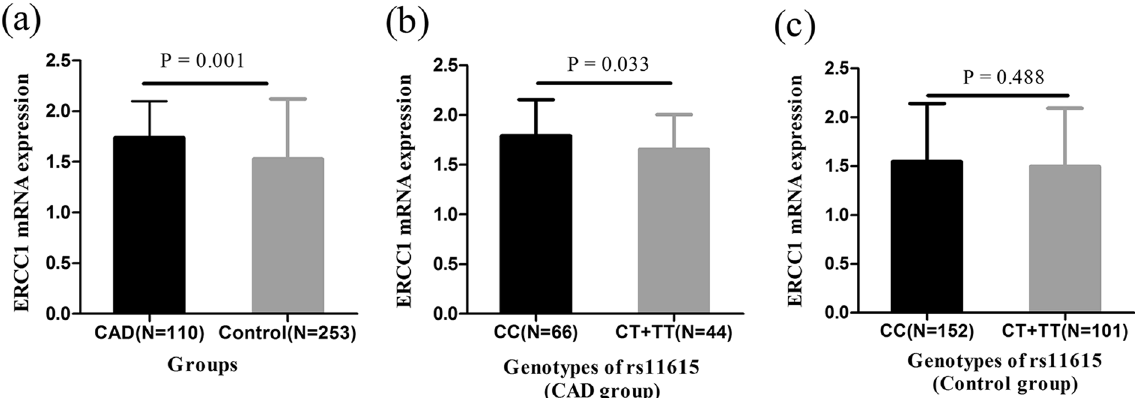
Figure 3. Associations of SNP rs11615 with ERCC1 mRNA expression. ERCC1 mRNA expression (1.74 ± 0.36 vs 1.53 ± 0.59) was higher in CAD group than control group ( a ); Associations of SNP rs11615 with ERCC1 mRNA expression in CAD group (1.79 ± 0.36 vs 1.66 ± 0.35) ( b ) and control group (1.55 ± 0.59 vs 1.50 ± 0.60) ( c ). ANCOVA models are used to assess statistical significance. Data are expressed as mean ± standard deviation